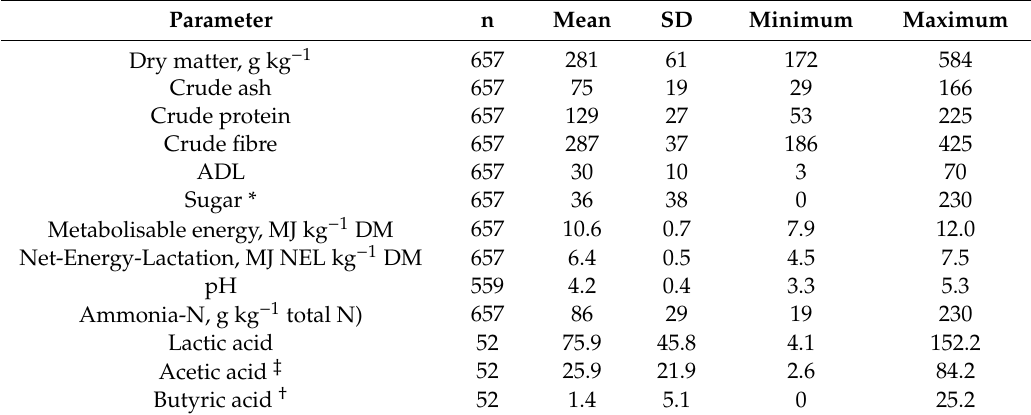
Table 1. Nutritive value and fermentation characteristics (g kg − 1 dry matter (DM), unless stated otherwise) of early-cut rye silages analysed in 2016–2018 by LKS mbH, Niederwiesa, Germany.